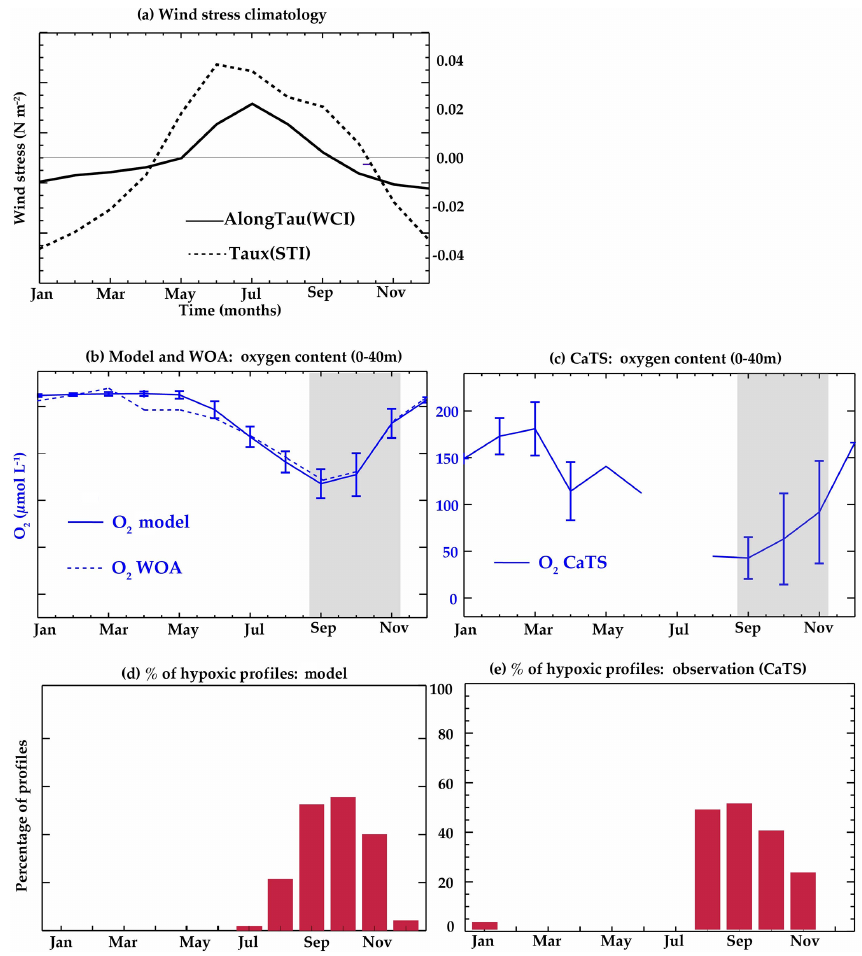
Figure 7. (a) Monthly climatological time series of alongshore wind stress in the WCI box (thick black curve) and zonal wind stress at the southern tip of India (STI; dashed black curve) with positive values denoting the upwelling-favorable winds. Monthly climatological time series of upper-ocean (0–40m depth) averaged oxygen (blue) (b) from the model (continuous) and WOA13 (dashed) in the WCI box and (c) from the in situ CaTS data. Vertical bars in panel (b) and (c) indicate ± 1 standard deviation around the mean value (displayed for CaTS data only when the number of years sampled for a given month exceeds 5). Percentage of profiles for each calendar month for which (d) oxygen concentrations below 80µmolL − 1 occur within the top 50m at WCI box in the model and (e) oxygen concentrations below 20µmolL − 1 occur within the top 20m in CaTS